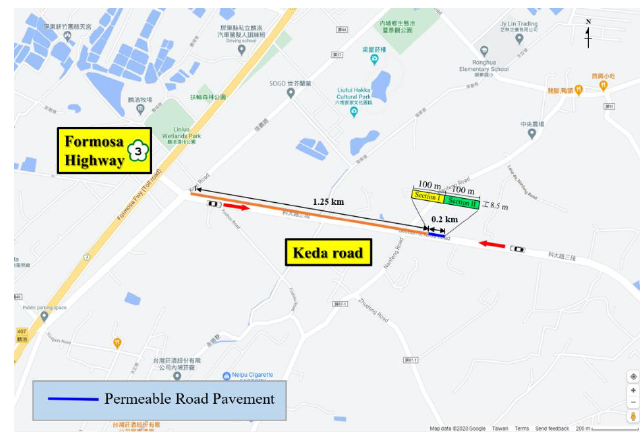
Figure 1. Location of the study area.